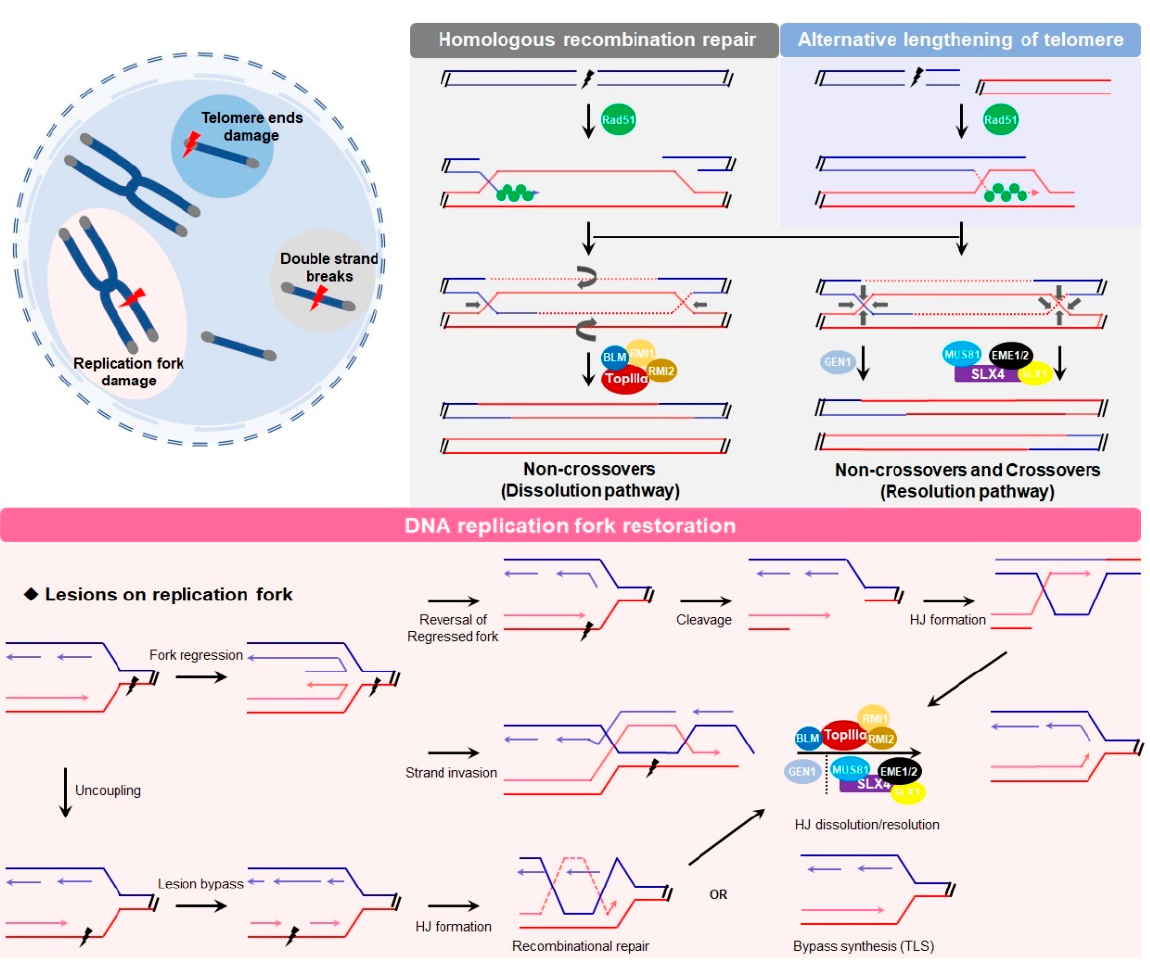
Figure 2. HJ-mediated repairs and the corresponding models. In HR and ALT pathway, the repair factor Rad51 binds one damage strand to initiate template search and strand invasion, resulting in the formation of single and double HJs, and these intermediates can be dissolved or resolved via different nucleases. In course of replication fork restoration, replication fork can undergo regression to form a single HJ when damage occurs, the end chain of single HJ invades into template to create a new HJ and then be removed by HJ nucleases. Besides, the regression may be reversed by BLM helicase, and the impaired fork may be cleaved to generate a single DSB for further recombinational repair. Again, the damage may be bypassed due to the discontinuous synthesis of DNA and even- tually become a single-strand gap, which can be repaired by bypass synthesis or recombinational gap-repair.